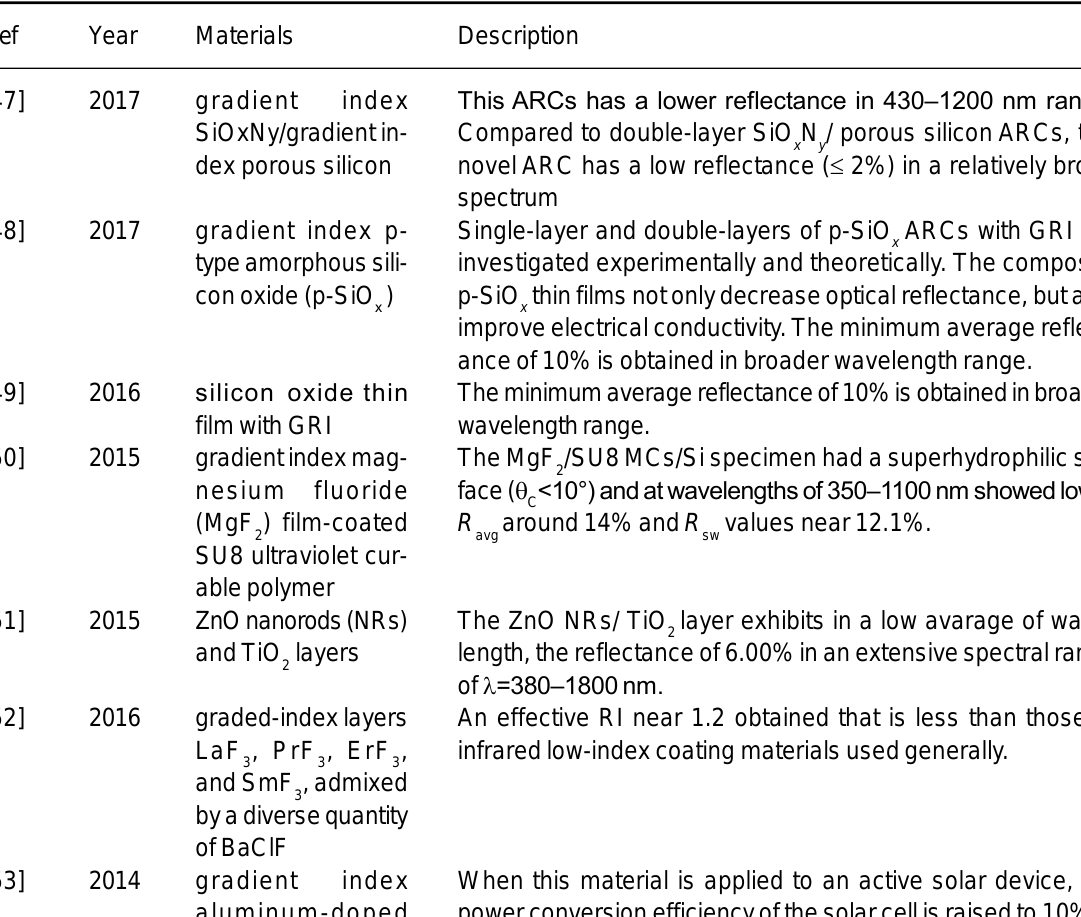
Table 3. A summary of gradient refractive index ARCs